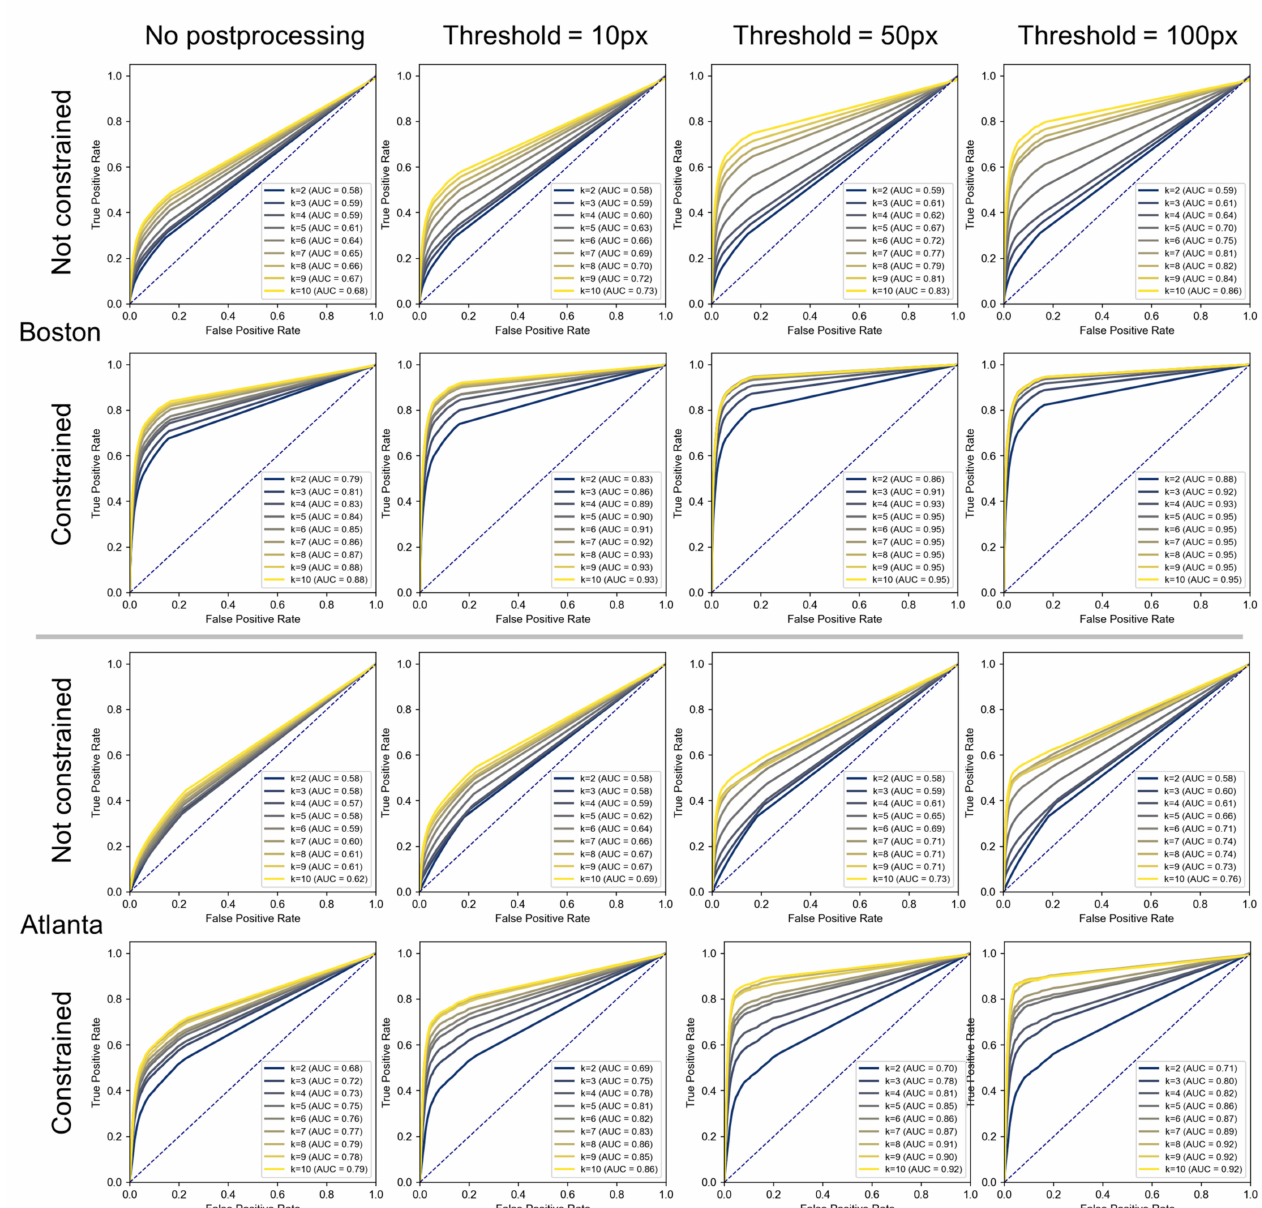
Figure A4. Extended ROC analysis of extracted urban/non-urban labels against the HISDAC-US BUPR